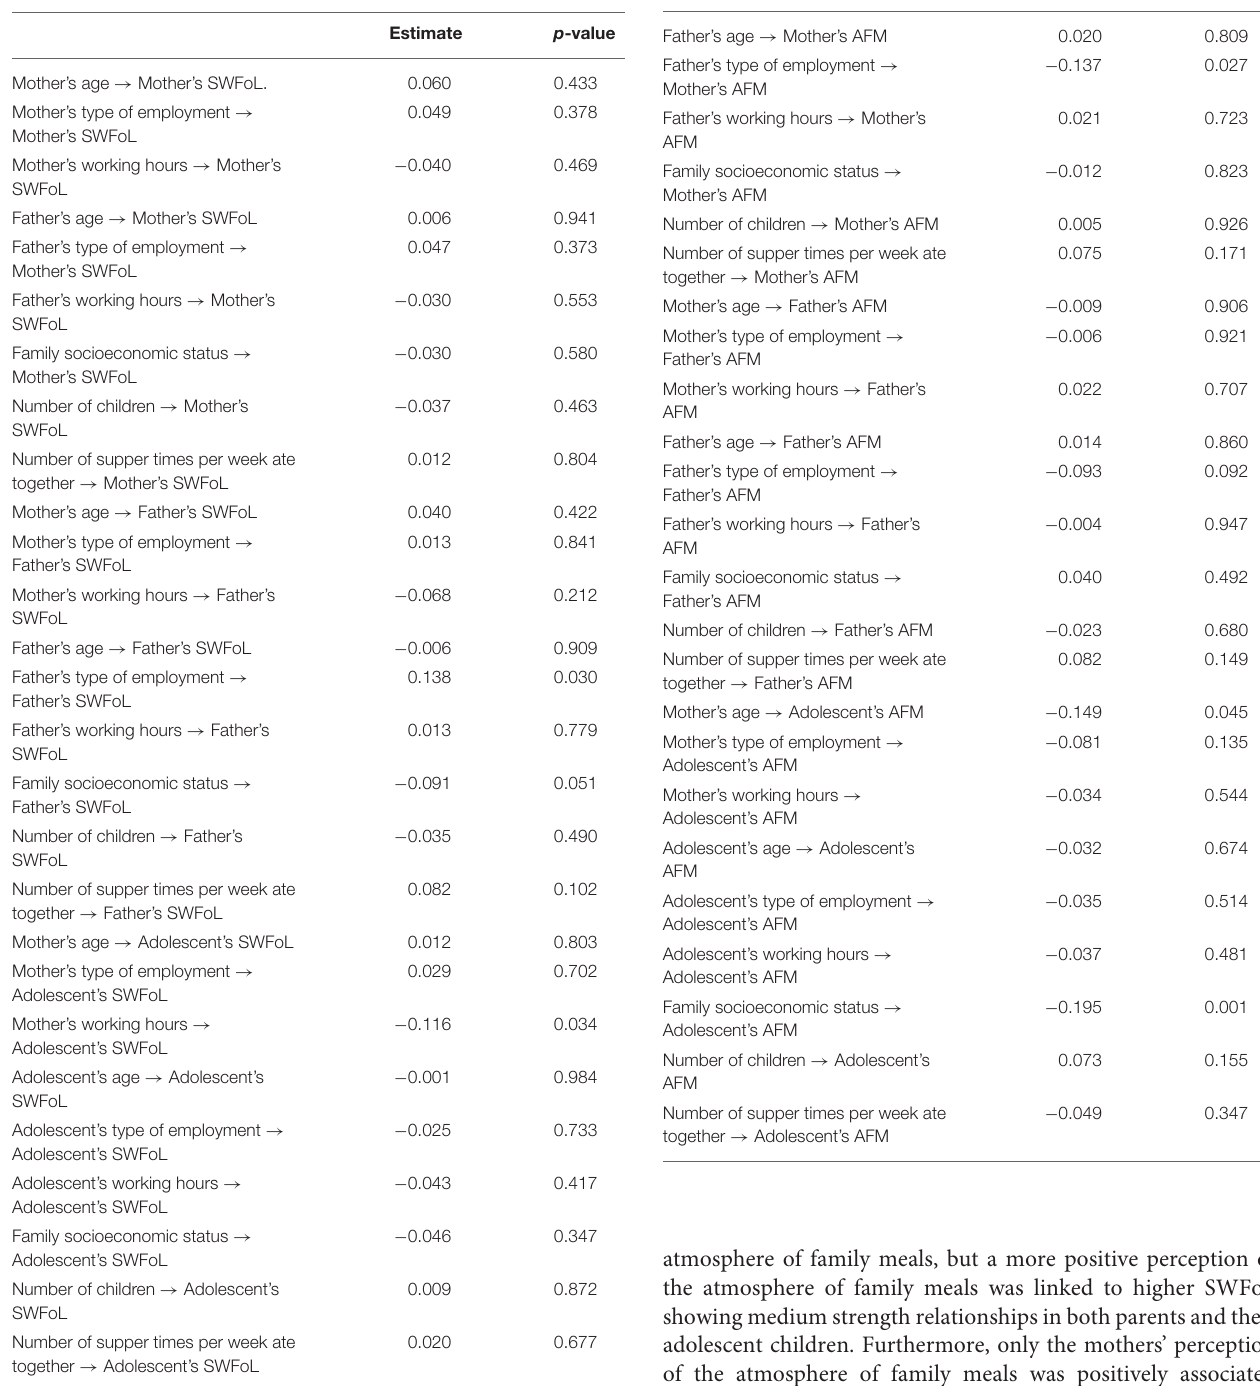
TABLE 3 | Standardized effects estimate of control variables on Satisfaction with Food-related life (SWFoL) and atmosphere of family meals (AFM) in dual-earner parents with adolescent